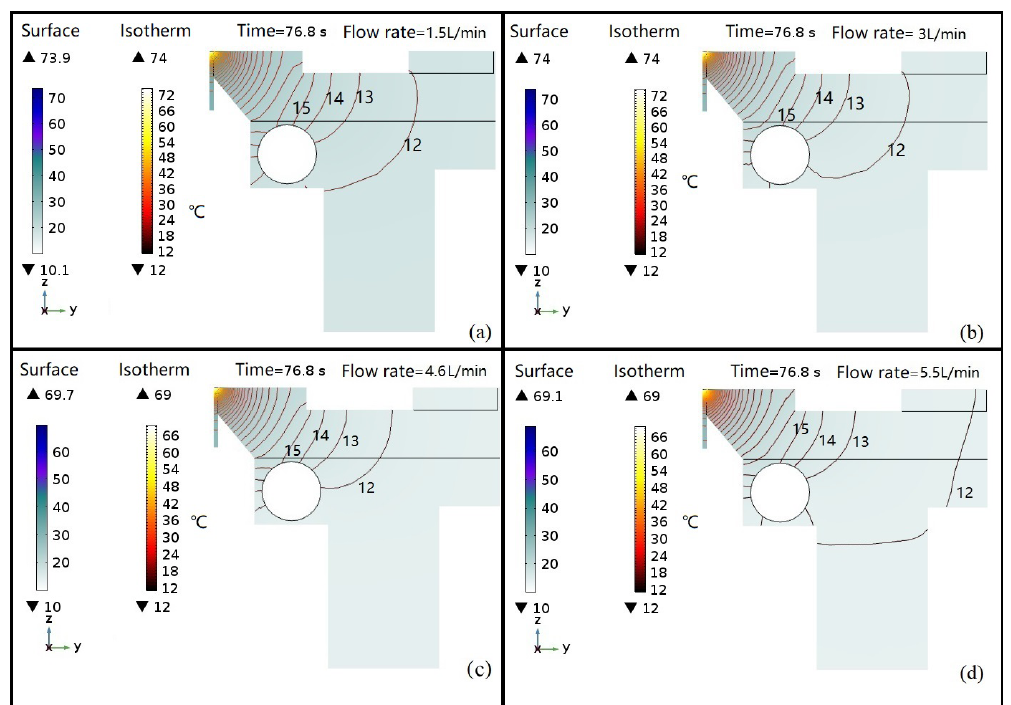
Figure 15. Isotherm distribution of cross section in the fixture at different flow rates.